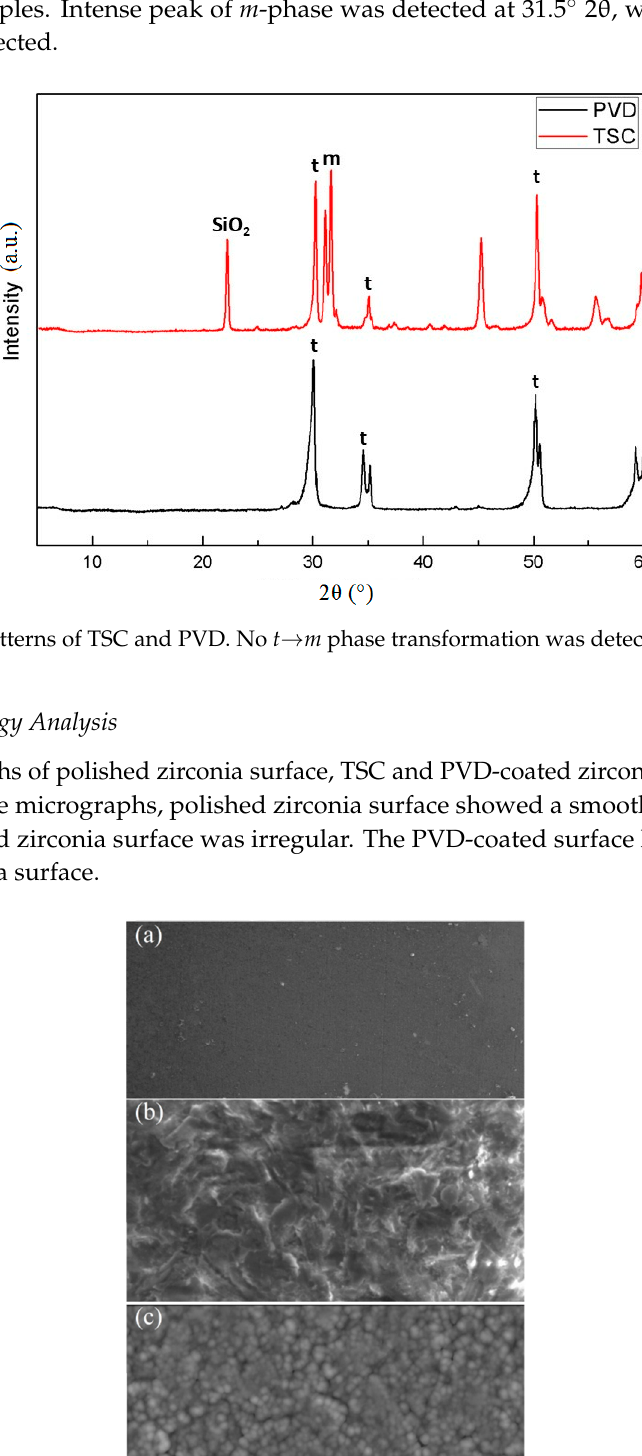
Figure 7. SEM micrographs showed smooth surface topography on ( a ) polished zirconia surface, typical irregular surface topography on ( b ) TSC zirconia surface, and regular silica particles morphology on ( c ) PVD-coated zirconia.